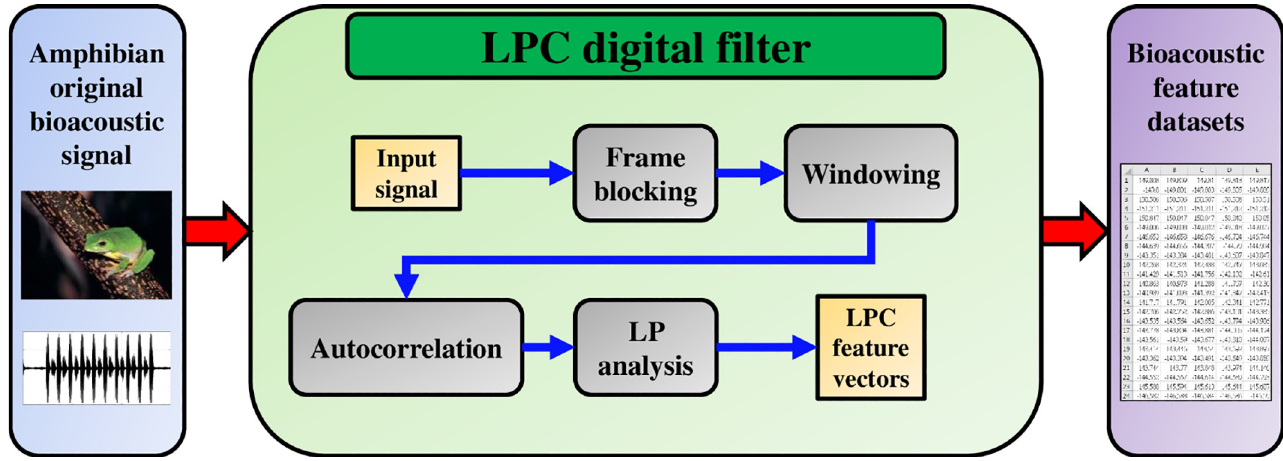
Fig 2. Shows our study based on LPC to construct the bioacoustic feature datasets.